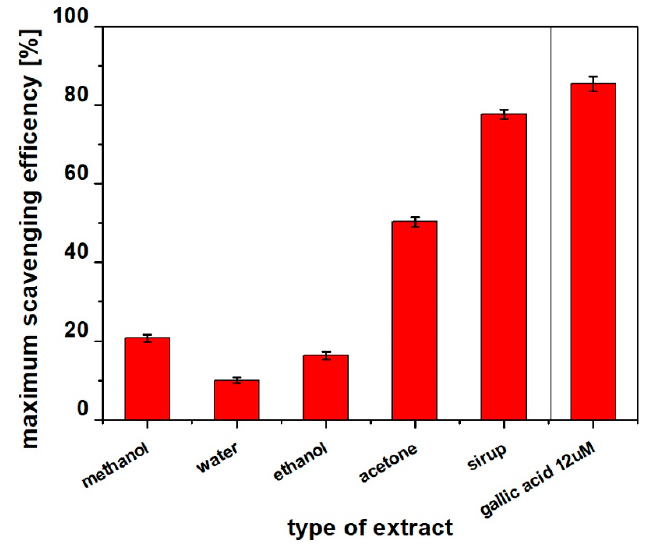
Figure 8. Maximum scavenging of DPPH free radical by extract examined.